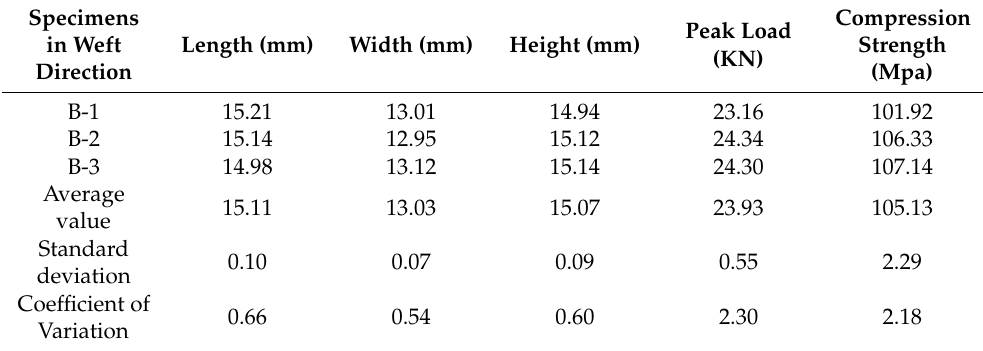
Table 3. Quasi-static compression test data for weft